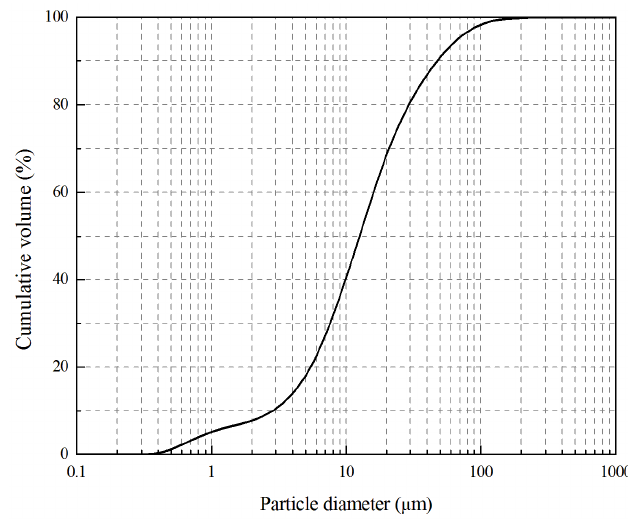
Figure 1. Particle size distribution of coal fly ash.